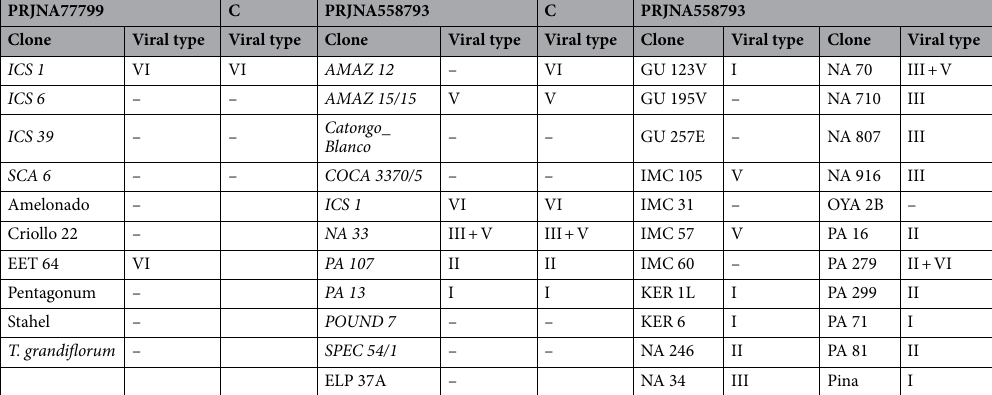
Table 1. Summary of findings from BioProject PRJNA77799 21 and BioProject PRJNA558793 47 , and comparison with findings from BioProject PRJNA486011 20 , designated as “C”. Italic font (except T. grandiflora ) indicates clones common to two or more